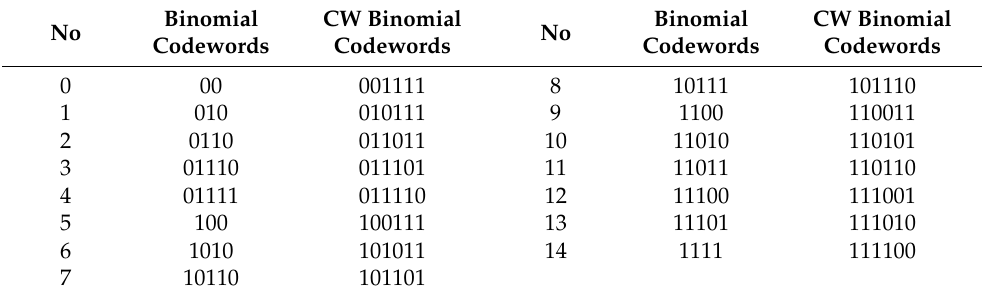
Table 3. CW binomial codewords with parameters n = 6, k =